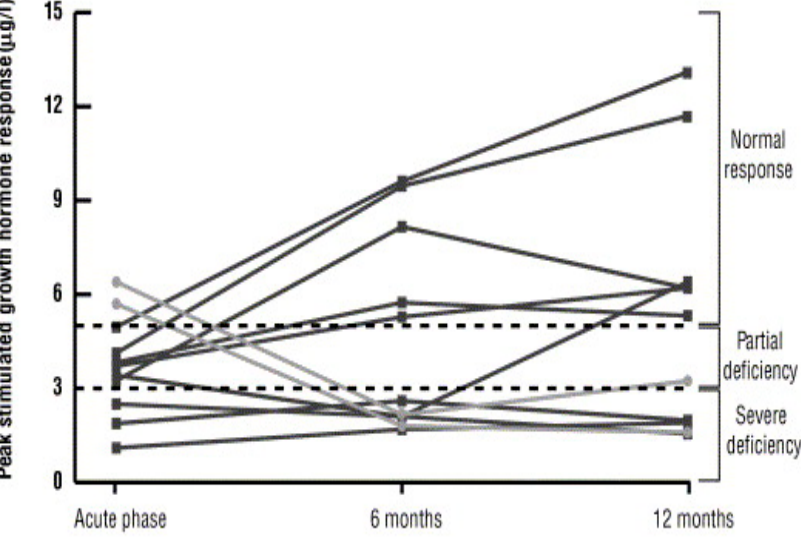
Figure 2. Peak growth hormone (GH) responses to glucagon stimulation in patients with early and late growth hormone deficiencies showing recovery of GH secretion in some patients in the post-acute phase, while others developed new deficiencies later in the chronic phase of TBI. Normal response is GH above 5 mcg/l. Image from senior author’s own study; Reference [112].